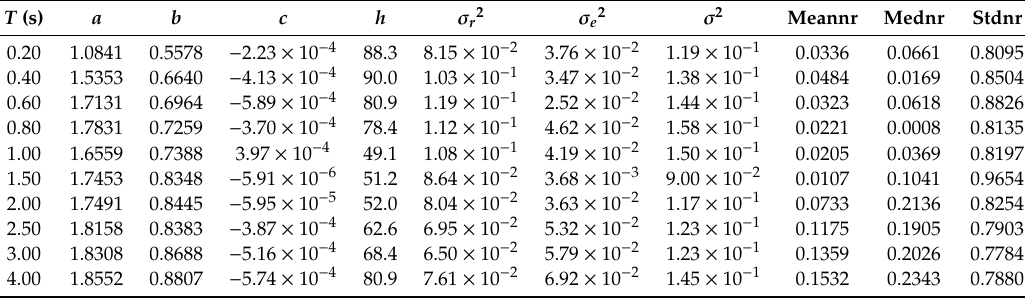
Table A3. Coe ffi cients of the GMPE for set 3, Equation (1), ground type B.